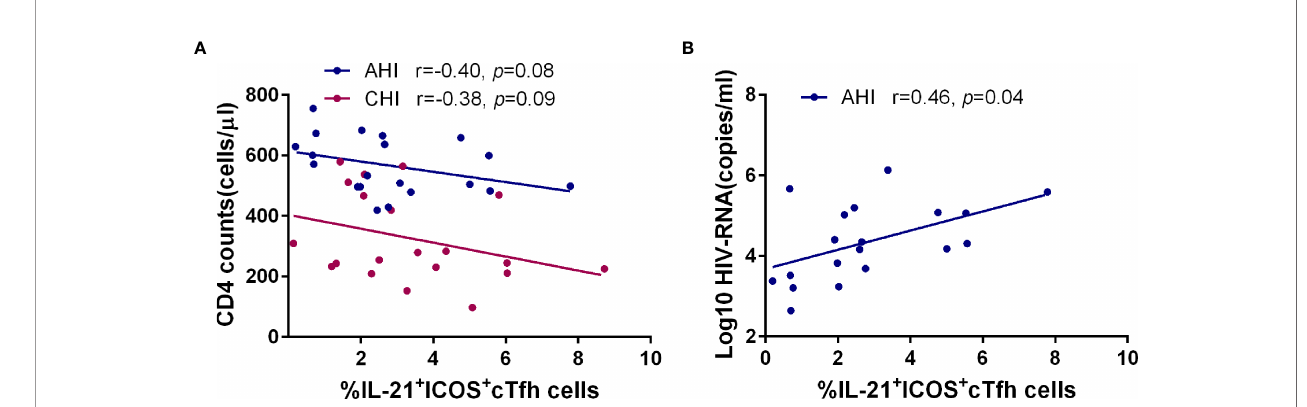
FIGURE 5 | The frequency of IL-21 + ICOS + cTfh cells in AHI is associated with the loss of CD4 + T cells and high plasma viral load. Correlation analysis of the frequency of IL-21 + ICOS + cTfh cells with CD4 + T cell number (A) and plasma HIV-1 viral load (B) in the AHI (n=20) and CHI